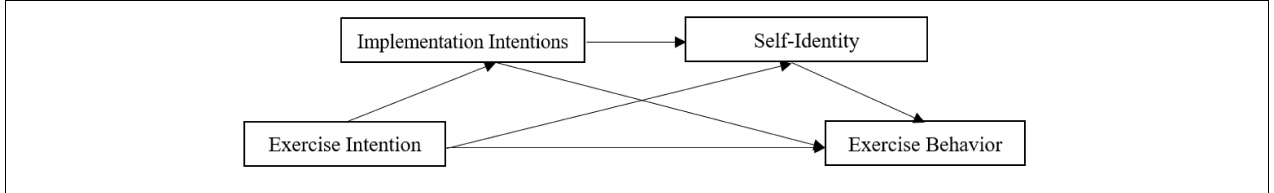
FIGURE 1 | Conceptual